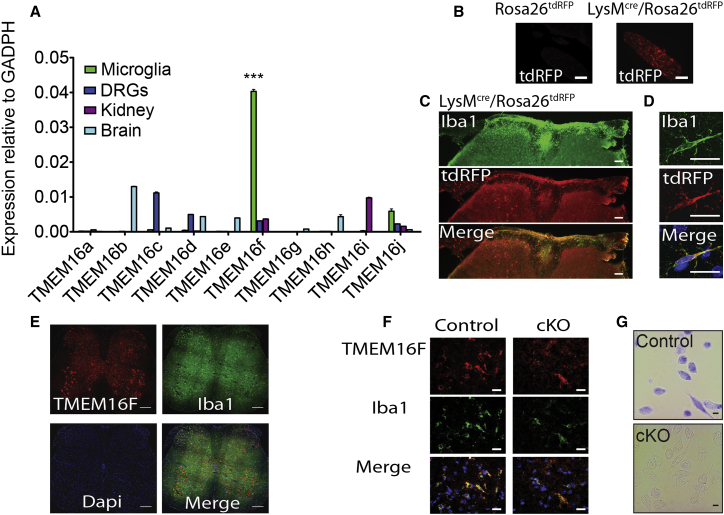
TMEM16 Expression and Generation of Conditional TMEM16F Knockout Mice(A) RT-PCR analysis of TMEM16 transcripts in microglia, dorsal root ganglia (DRGs), kidney, and brain; p < 0.0001; n = 3.(B) Representative images of injured sciatic nerve from indicated genotypes, 7 days after injury.(C) Iba1 (green) and RFP (red) immunofluorescence in the lumbar spinal cord LysMCre/Rosa26tdRFP mouse, 3 days after injury.(D) Iba1 (green) and RFP (red) immunofluorescence of microglia in the hippocampus from LysMCre/Rosa26tdRFP mouse.(E) In situ hybridization for TMEM16F (red) and Iba1 (green) immunofluorescence of microglia in spinal cord, 7 days after injury.(F) High-magnification representative images of TMEM16F in situ hybridization in control and cKO mice.(G) In situ hybridization for TMEM16F in peritoneal macrophages cells from control and cKO mice.Values are mean ± SEM. Scale bars, 100 and 40 μm (B), 100 μm (C), 20 μm (D, F, and G), 300 μm (E). See also Figure S1.